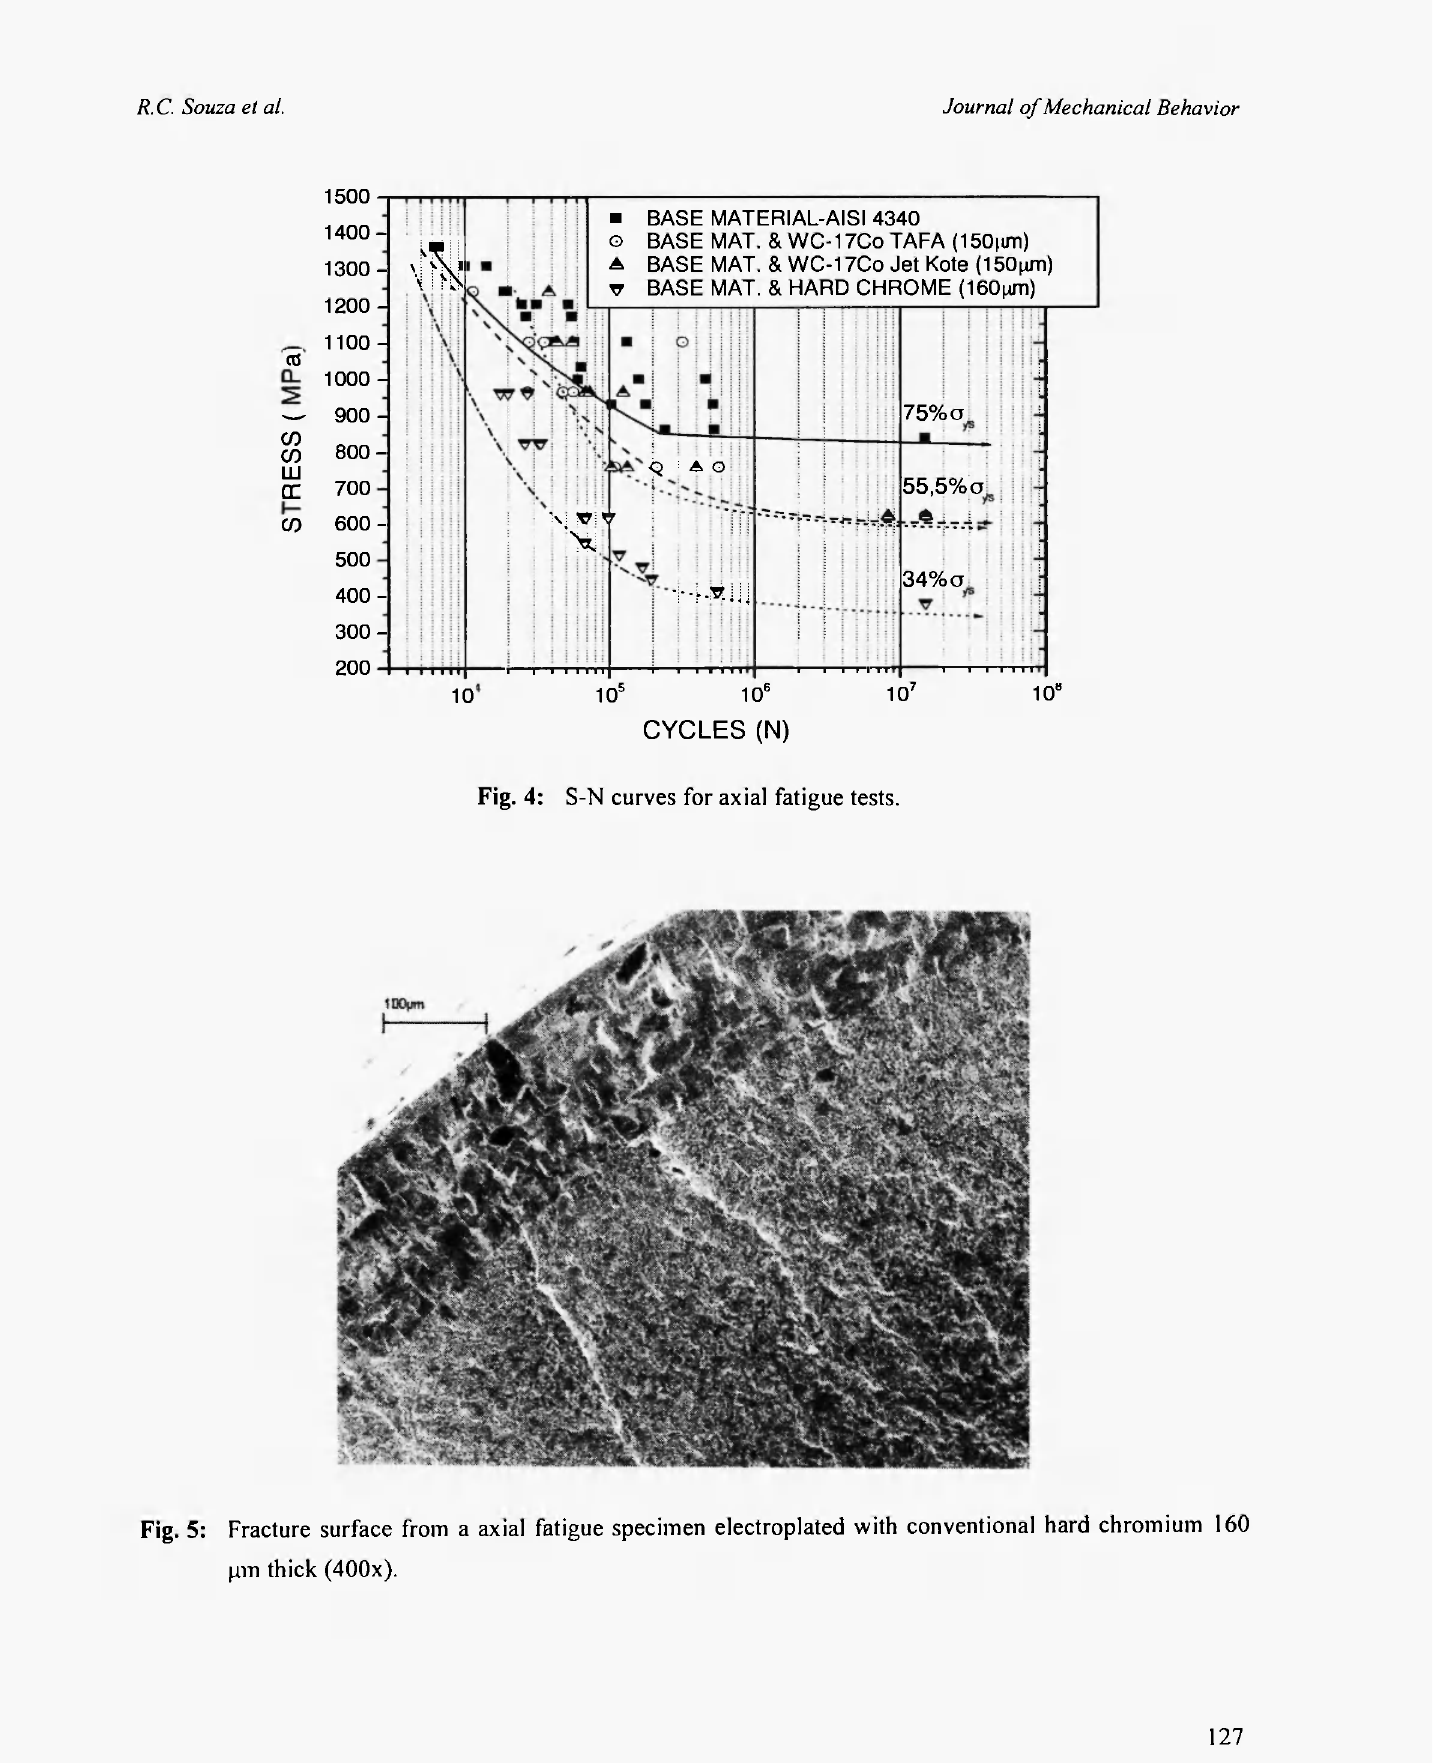
Fig. 4: S-N curves for axial fatigue tests.